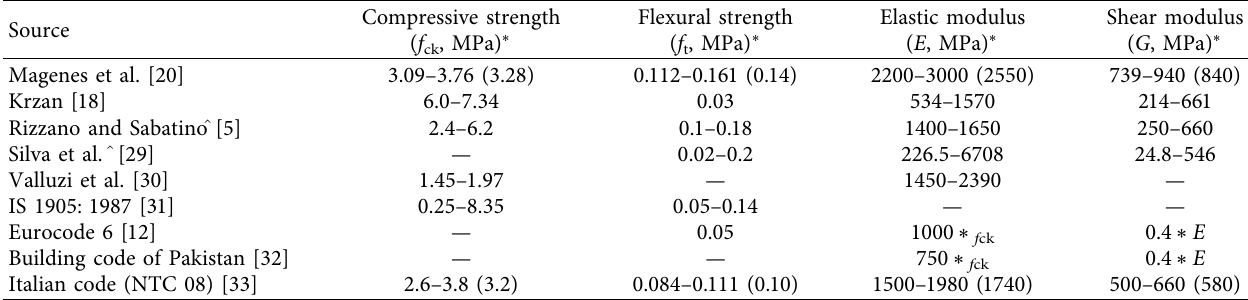
Table 1: Mechanical properties of stone masonry from experiments and codes.